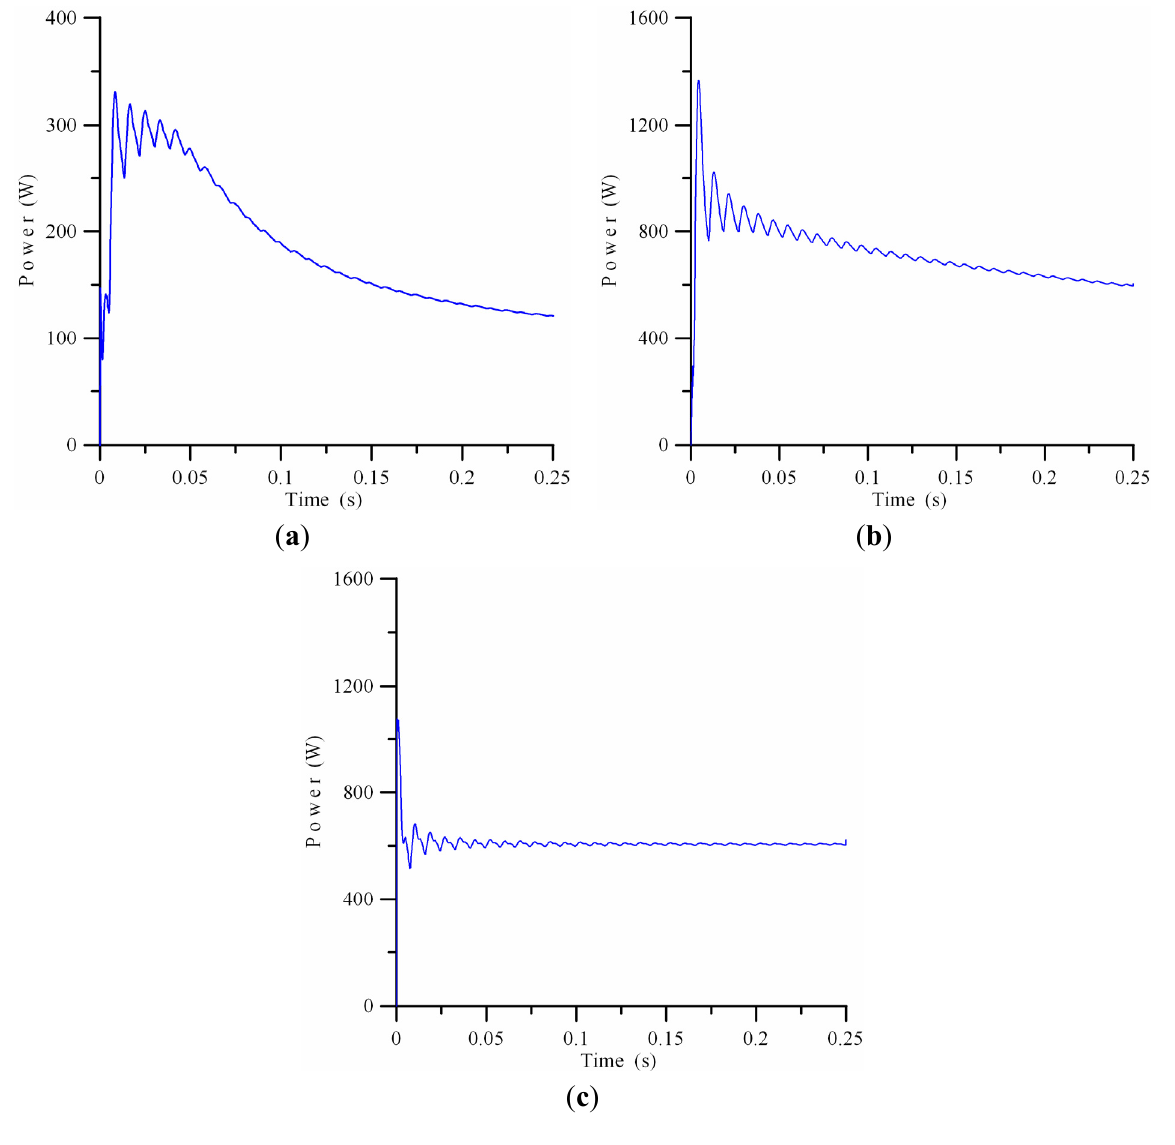
Figure 10. Experiment of load turn-on instantaneous transient power for case 4. ( a ) a 119 W dehumidifier; ( b ) a 590 W vacuum cleaner; ( c ) an R-L linear load with P and Q equivalent to that of a 590 W vacuum